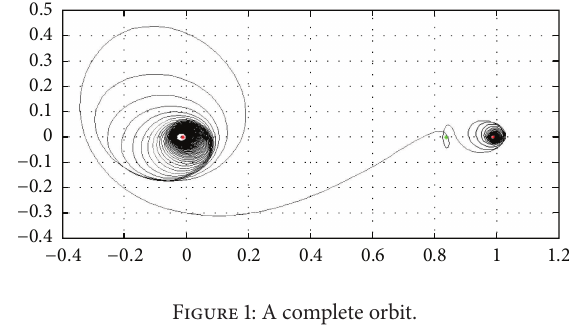
Figure 1: A complete orbit.